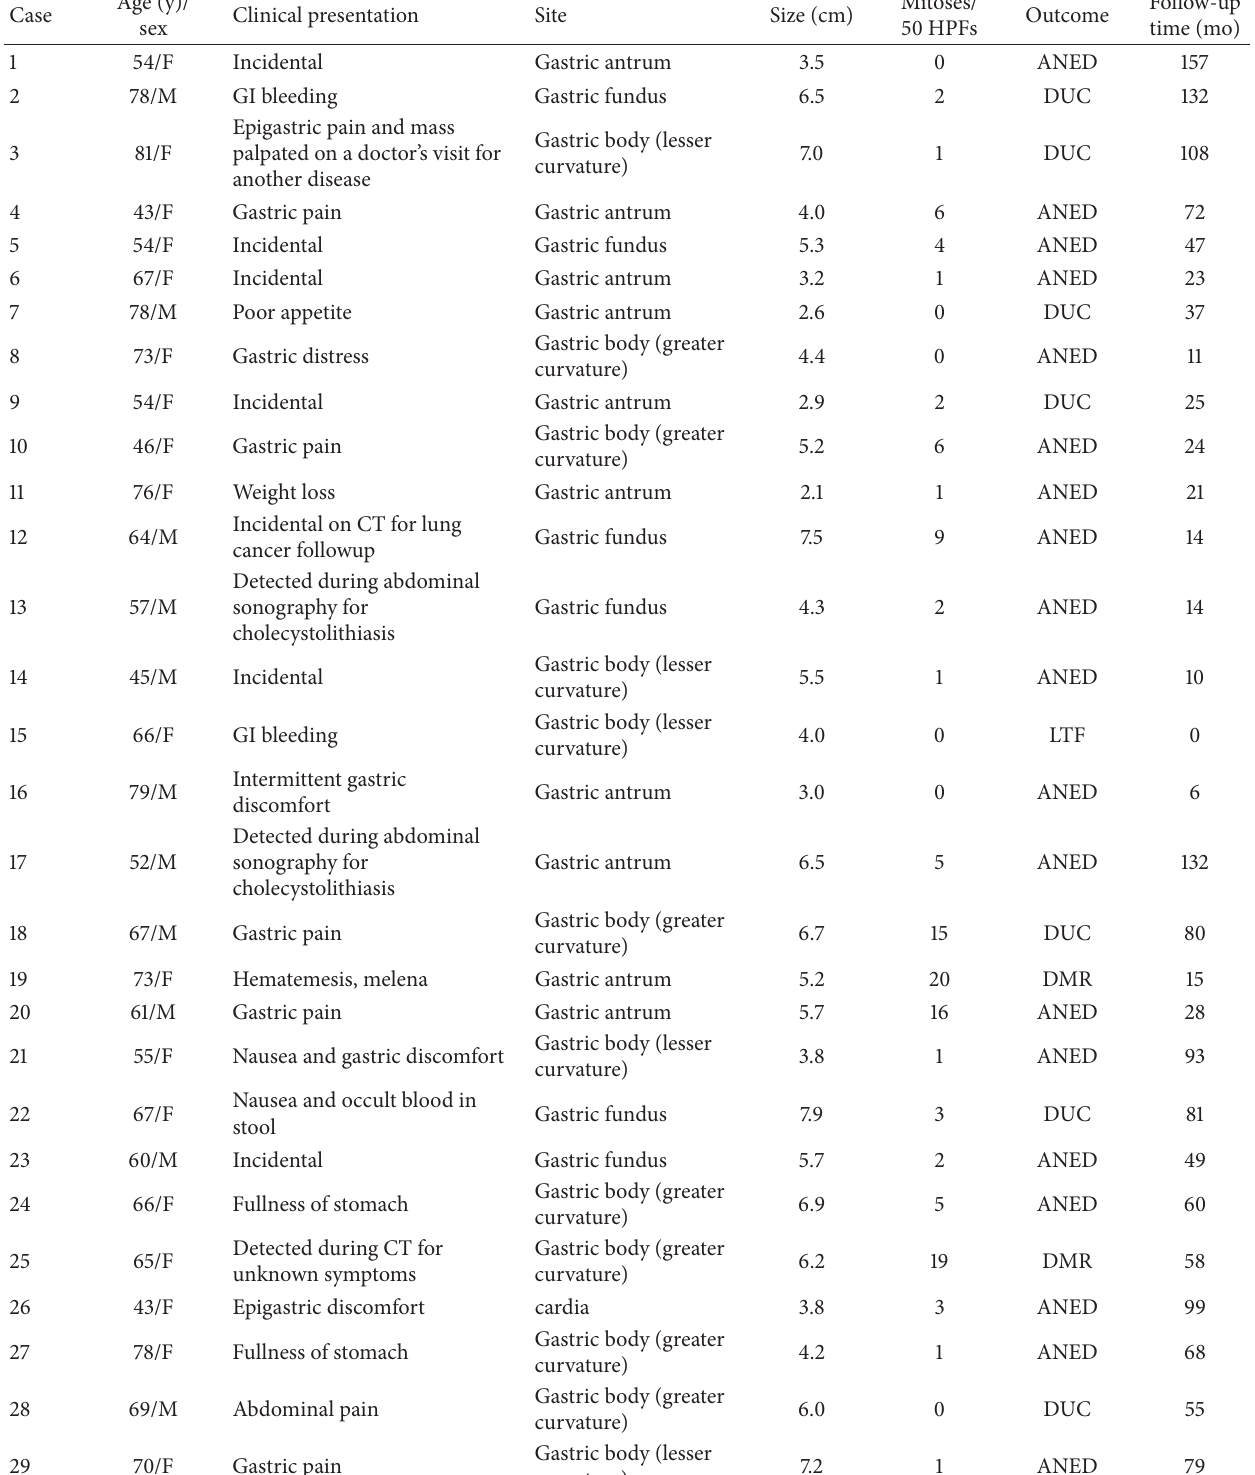
Table 1: Clinicopathologic features of 29 cases of gastric